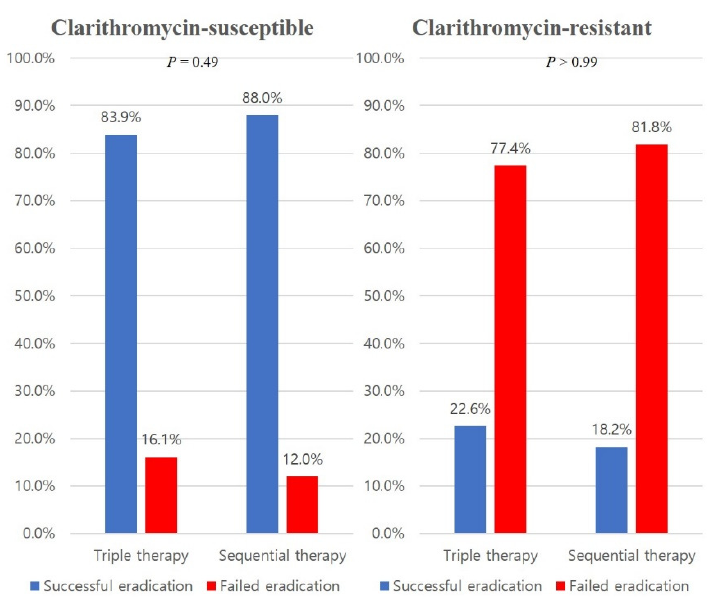
Figure A1. Comparison of the eradication rates between triple therapy and sequential therapy according to clarithromycin susceptibility.